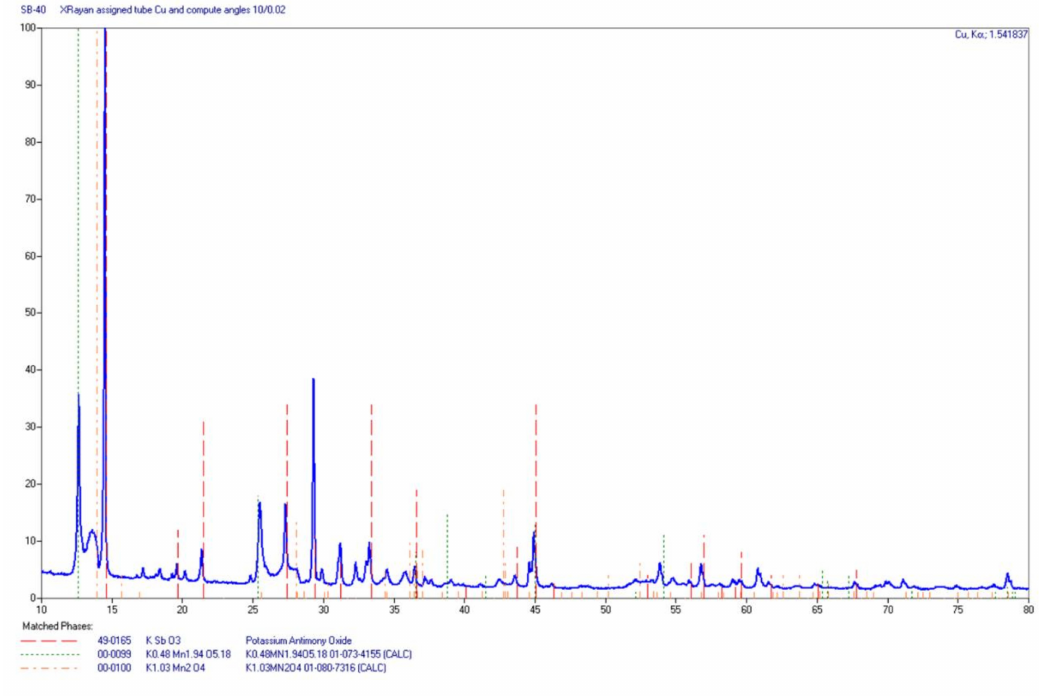
Figure 10. Diffractogram of the residue of the composition containing 40 wt% Sb.